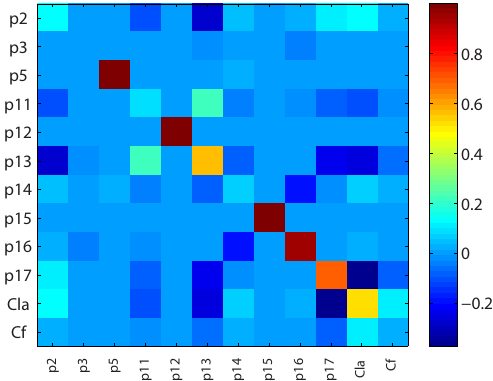
Figure 8. Model resolution matrix for the LAI operator using TSVD with truncation rank k = 5.